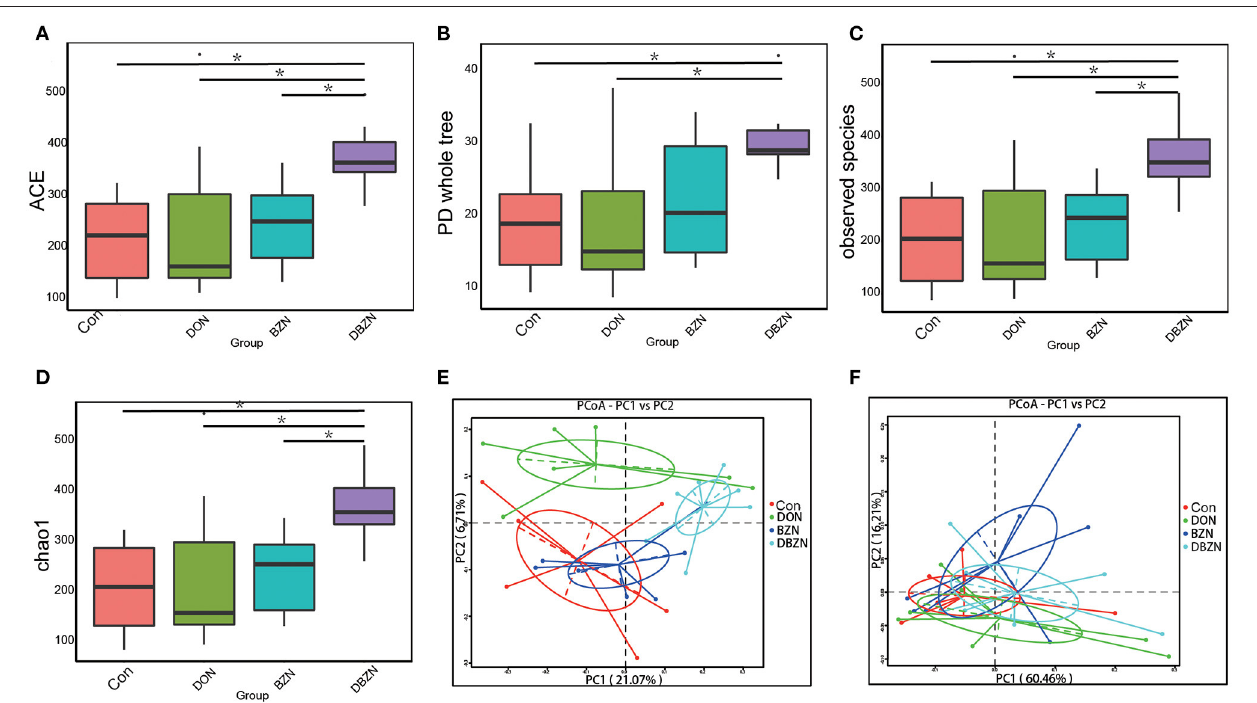
FIGURE 2 | Alpha and beta diversity change of gut microbiota. (A) Alpha diversity base on the ACE index. (B) Alpha diversity base on the Phylogenetic diversity (PD) whole-tree index. (C) Alpha diversity base on the observed species index. (D) Alpha diversity base on the chao 1 index. (E) Principal coordinate analysis (PCoA) based on the binary Jaccard indices. (F) PCoA based on the weighted UniFrac indices. Dietary treatment: Con, basal diet; DON, 4 mg/kg DON-contaminated diet; BZN, 0.5% BZN supplementation diet; DBZN, 0.5% BZN supplement in 4 mg/kg DON-contaminated diet. * p < 0.05. BZN, baicalin–zinc complex; Con, control; DON,